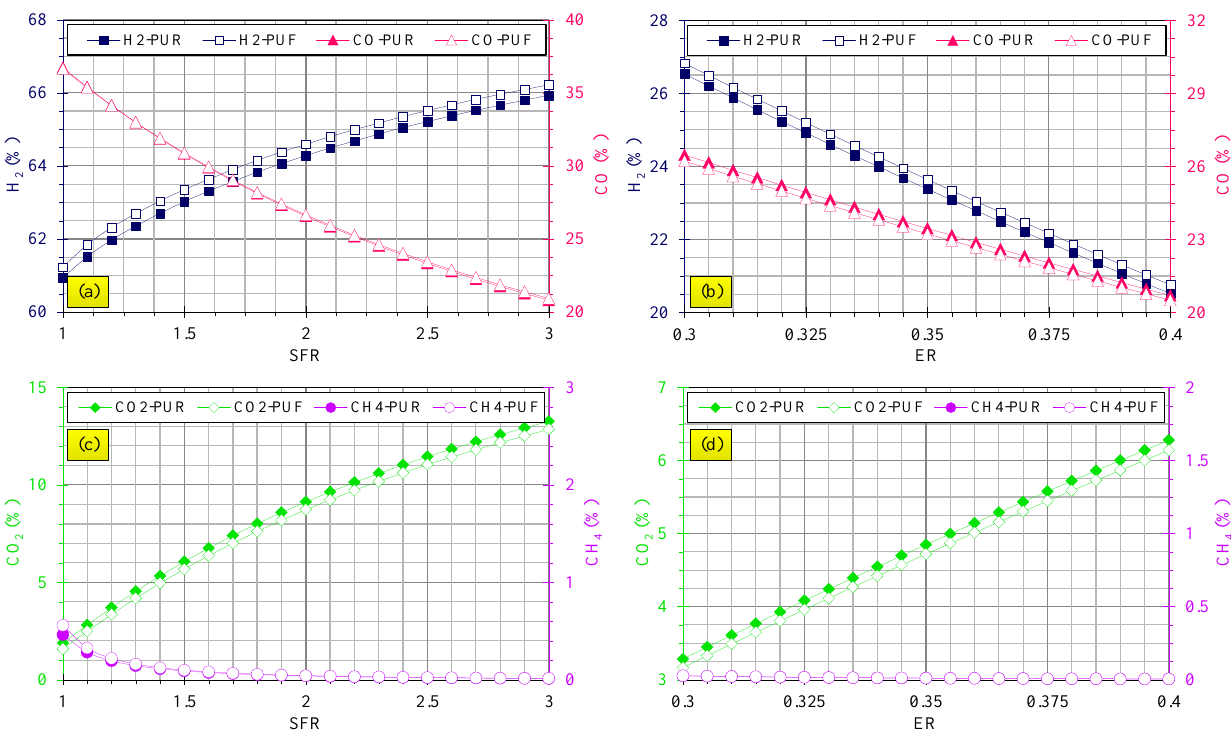
Figure 2. Effects of SFR and ER on syngas composition. ( a ) Effects of steam/waste PU foam ratio on H 2 and CO yields in steam gasification, ( b ) effects of equivalence ratio on H 2 and CO yields in air gasification, ( c ) effects of steam/waste PU foam ratio on CO 2 and CH 4 yields in steam gasification and ( d ) effects of equivalence ratio on CO 2 and CH 4 yields in air gasification.